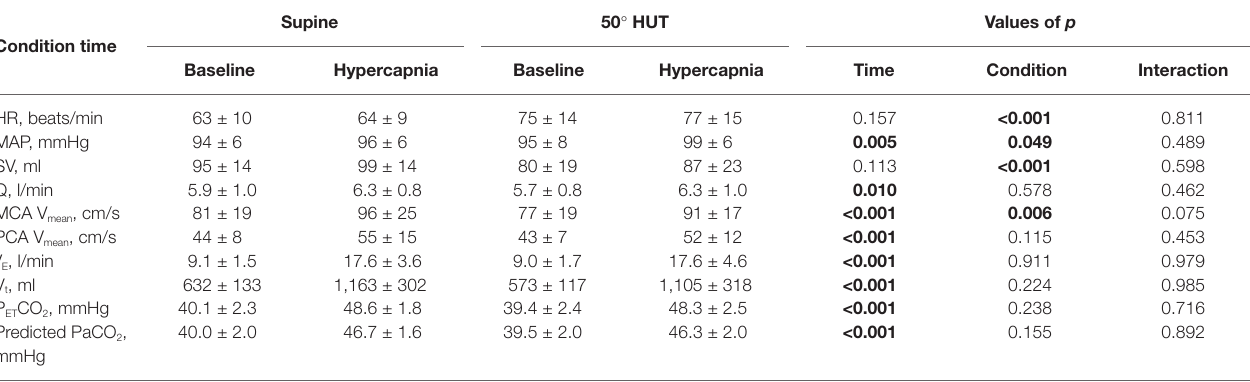
TABLE 1 | Hemodynamic and respiratory variables during baseline and hypercapnia.